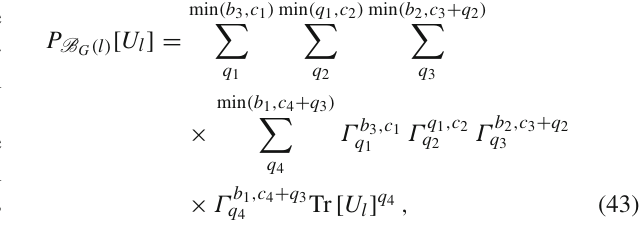
As for the green path, expressions for the coefficients ˜ c i , are given in “Appendix A”. Thepolynomialscomingfromperformingtheintegrations over the green and blue paths are computed in “Appendix